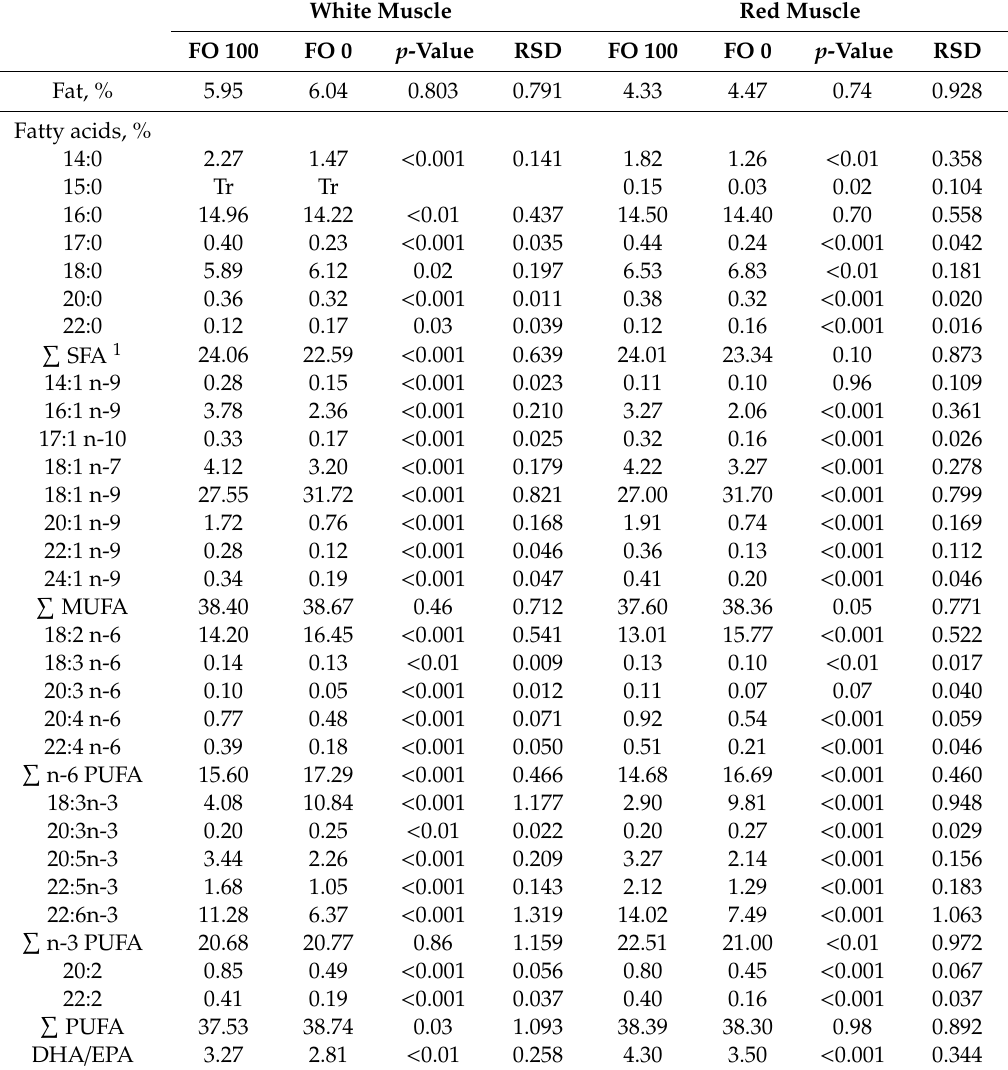
Table 2. Fat content (%) and fatty acid composition (% of total fatty acids content) of white and red muscles at the beginning of the wash-out period in S. dumerili always fed FO 100 and FO 0 diets (12 fish per diet): e ff ect of the grow-out diet. Values are expressed as least square (LS)